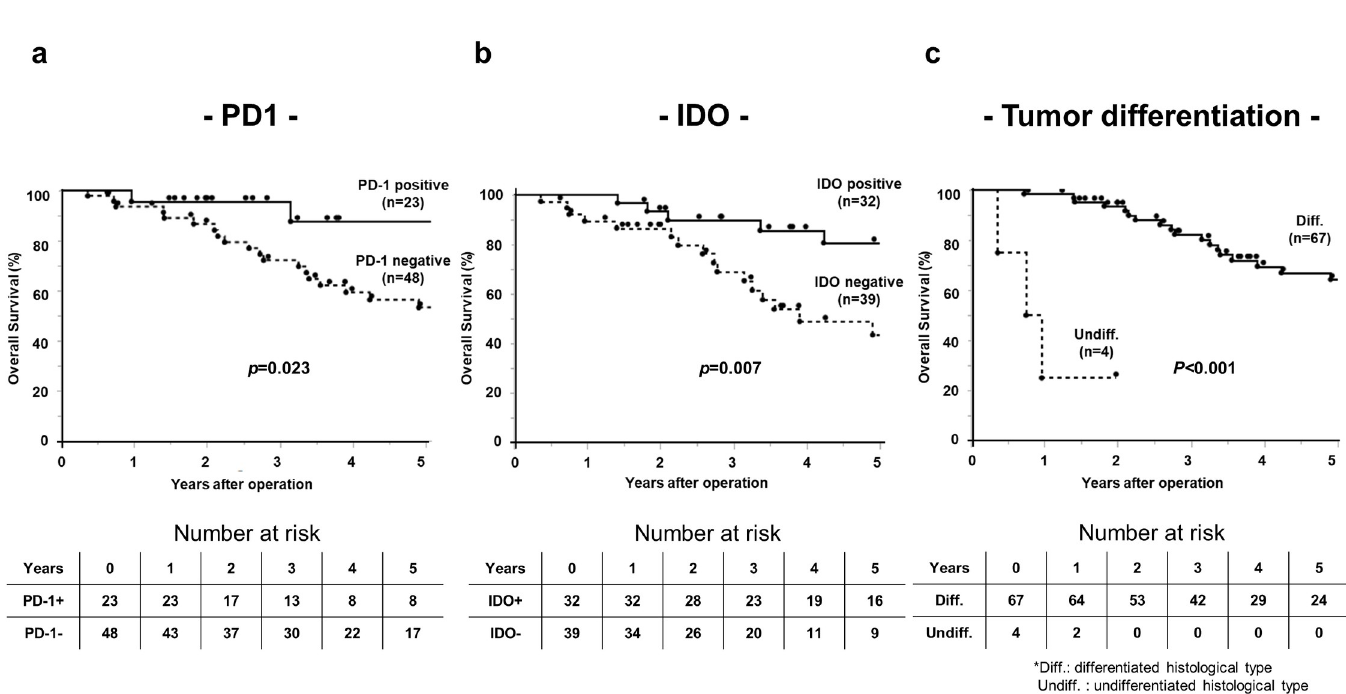
Fig 3. Overall survival rates of patients with CRLM post-hepatectomy according to PD-1, IDO expression and differentiation. a. PD-1 expression, b. IDO expression, c. Tumor differentiation.